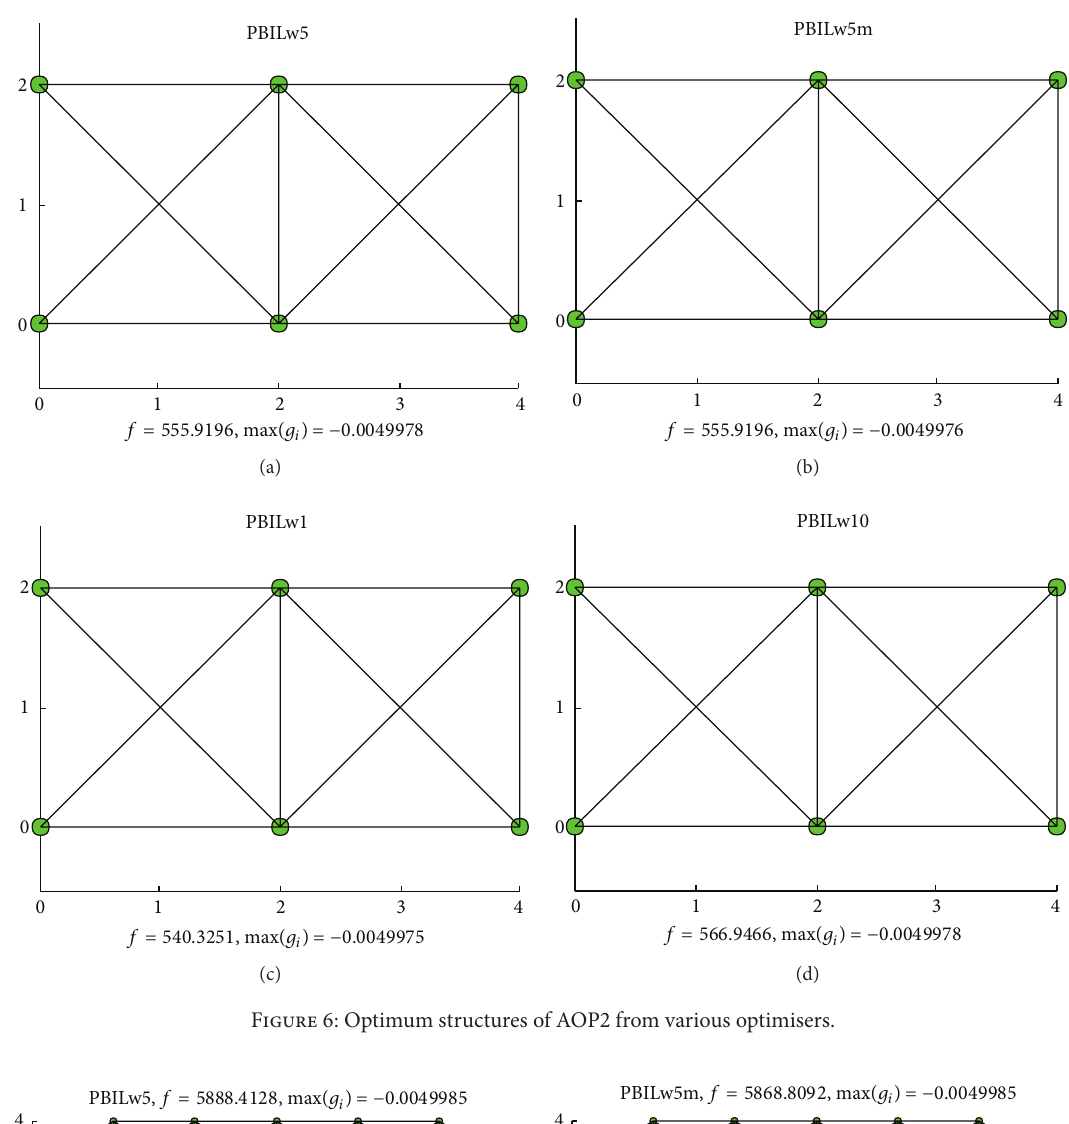
Figure 6: Optimum structures of AOP2 from various optimisers.